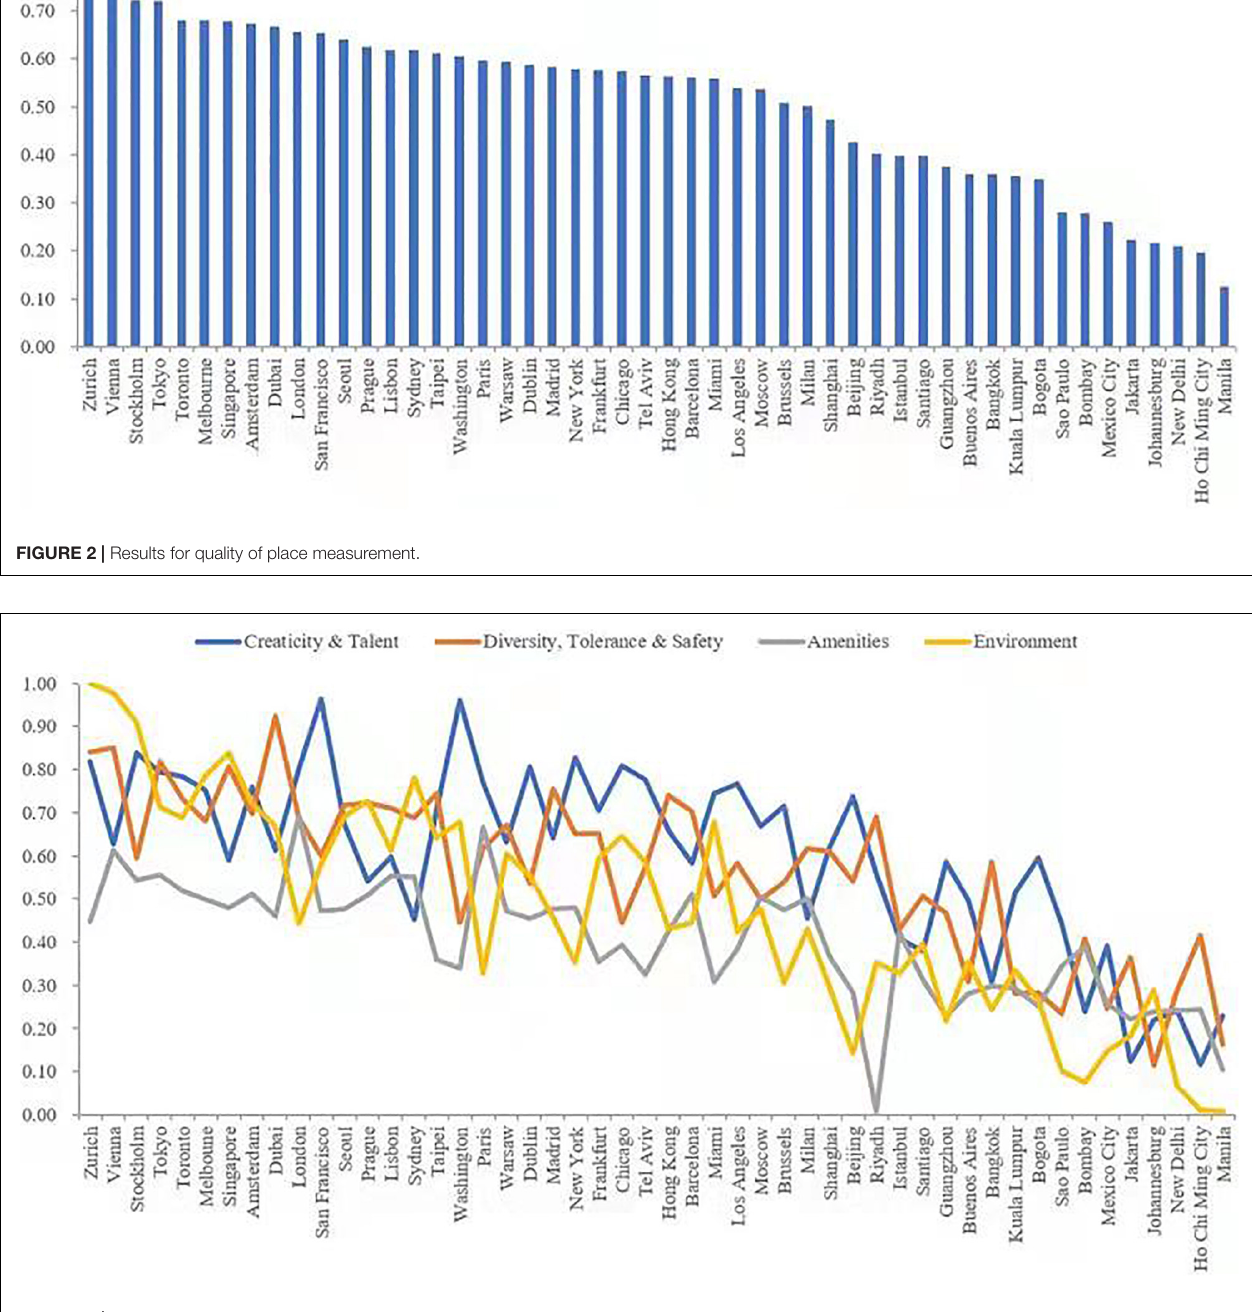
FIGURE 3 | Result for the four-dimensional measurement of quality of